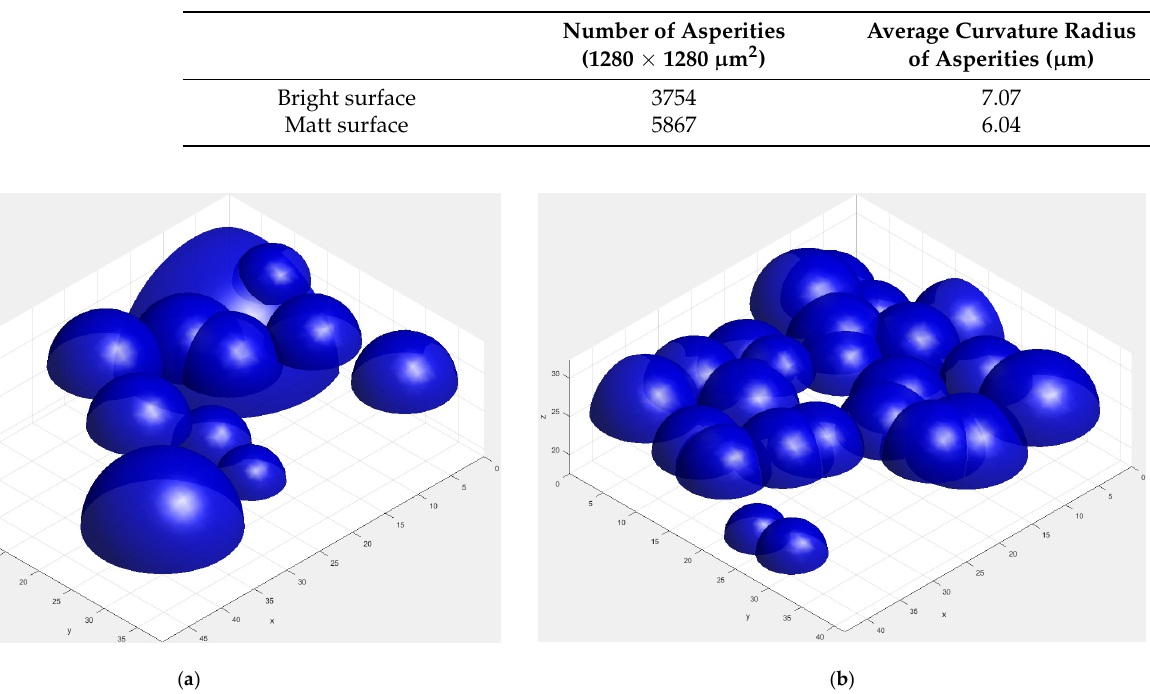
Table 2. The statistical parameters of the asperities for electrodes with bright and matt surfaces.